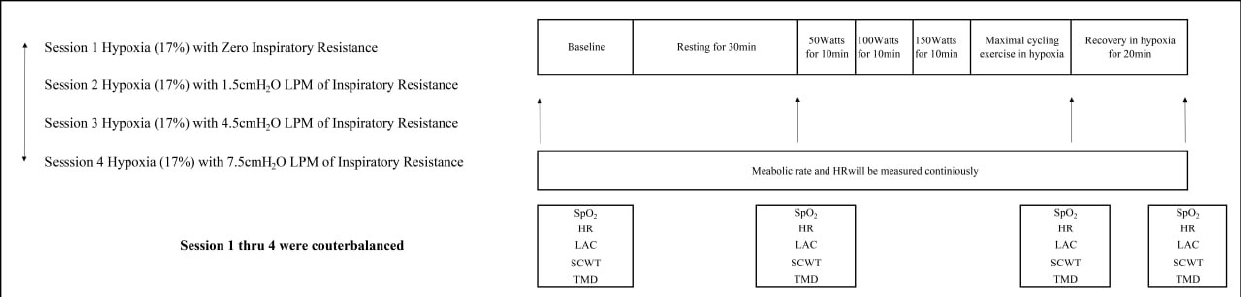
Figure 1. The experimental procedure and timeline. SpO 2 : peripheral oxygen saturation; HR: heart